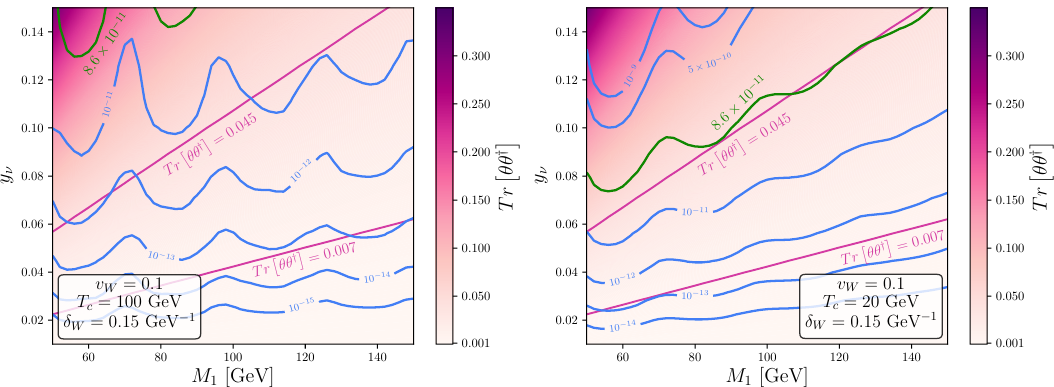
Figure 7 . Resulting baryon asymmetry as a function of the Yukawa coupling y heavy neutrino mass M 1 in the vanilla case for two di(cid:11)erent temperatures of the phase transition, T c = 100 GeV (left panel) and T c = 20 GeV (right panel). The masses of the other two heavy neutrinos are M 2 = M 1 + 10 GeV and M 3 = M 2 + 10 GeV while m D has been (cid:12)xed as discussed at the end of section 2. Along the green line the observed BAU is reproduced. The value of Tr is represented by the color bar legend, while the current bound for this quantity is represented with the two magenta lines for Tr = 0 : 045 taking into account or not the invisible width of the Z ,